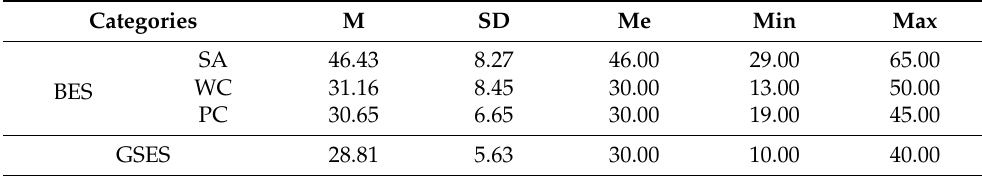
Table 2. Body esteem and self-efficacy of pregnant